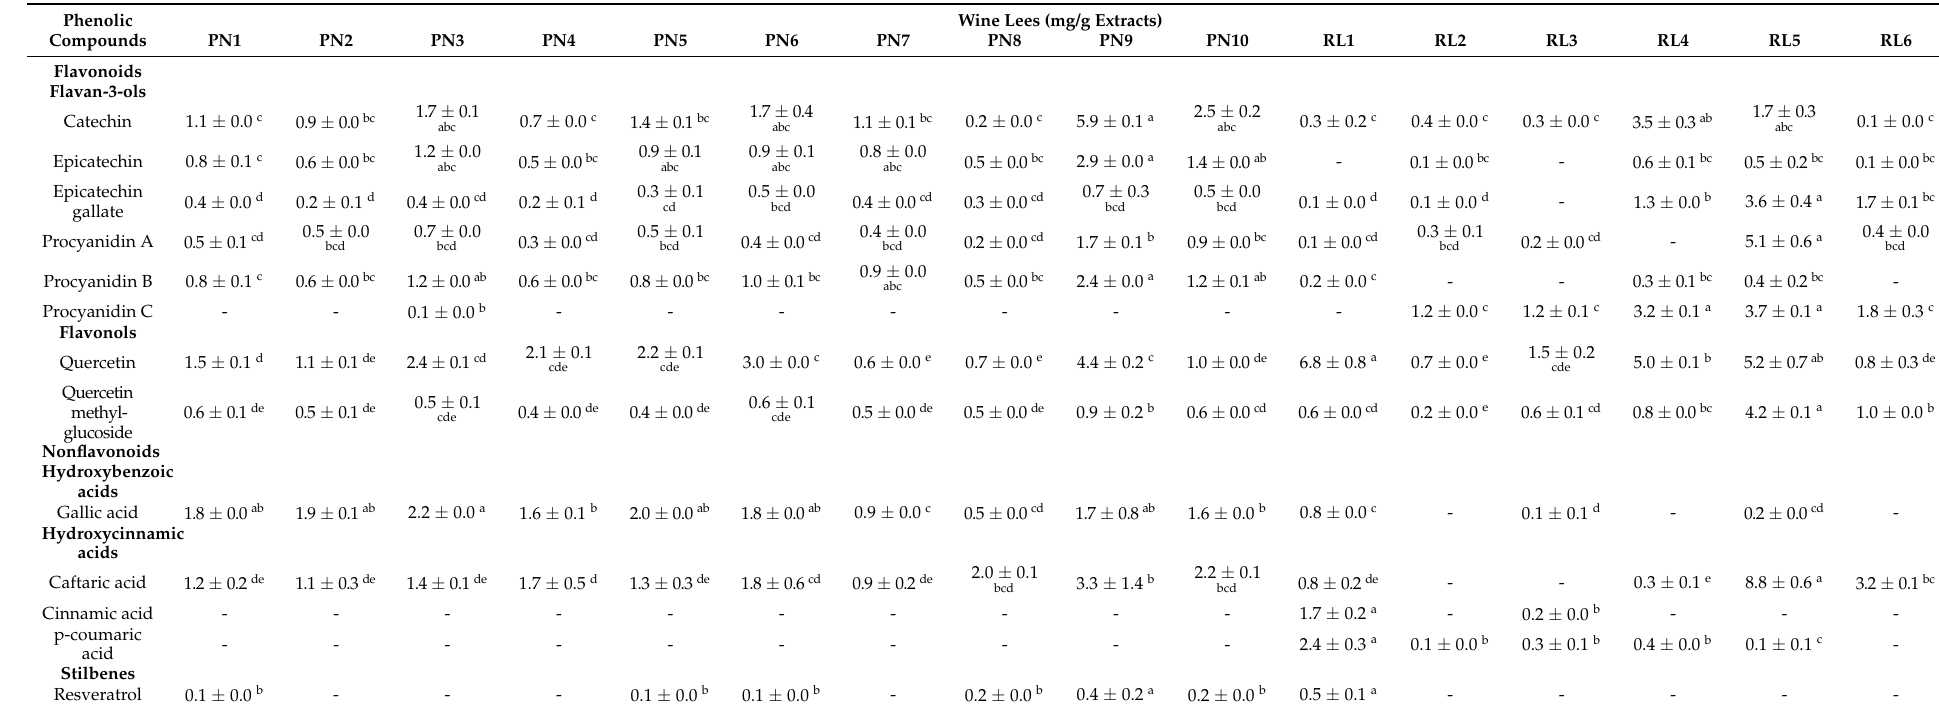
Table 2. Phenolic profile of PN and RL lees extracts (mg/g extracts) quantified by LC-MS